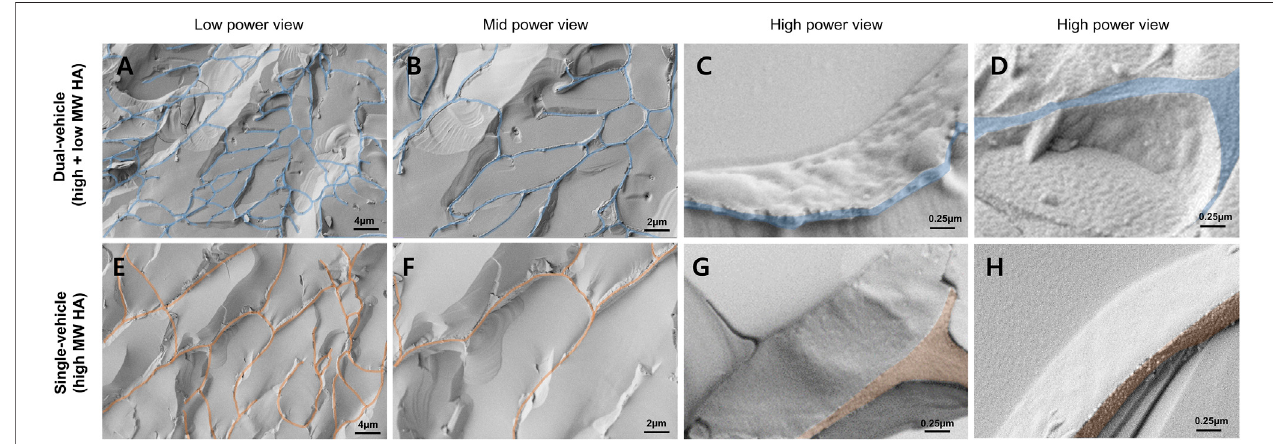
FIGURE 1 | Cryo-scanning electron microscopy of the dual-vehicle. The slab-like structures are the interconnected fi brous hyaluronic acid (HA) network. The cuttingplanesofthe fi brousHAnetworkwerecoloredcodedinblueandred.Theglass-likestructureinsidetheHAnetworkarethefrozenaqueousmedia.Comparedto the single-vehicle [only high molecular weight (MW) hyaluronic acid, (E,F) ], the average pore dimension was smaller in the dual-vehicle (A,B) . Also, freezing of the two different phases of HA made the surface texture of the fi brous HA network more granular (C,D) . Surface texture of the single-vehicle HA network was very smooth (G,H)